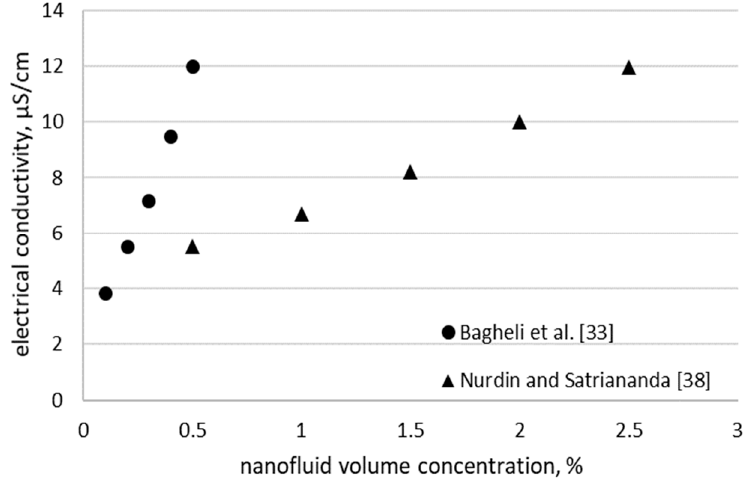
Figure 2 . Electrical conductivity of iron oxide - water nanofluid. Figure 2. Electrical conductivity of iron oxide-water